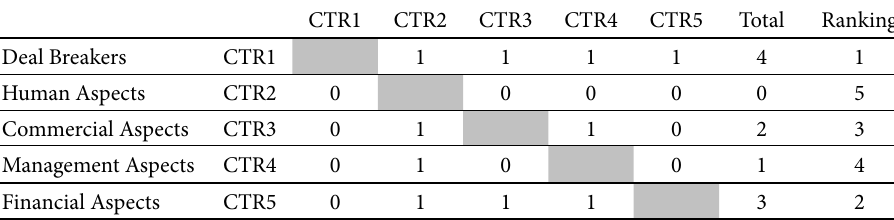
Table 3. CTR order matrix